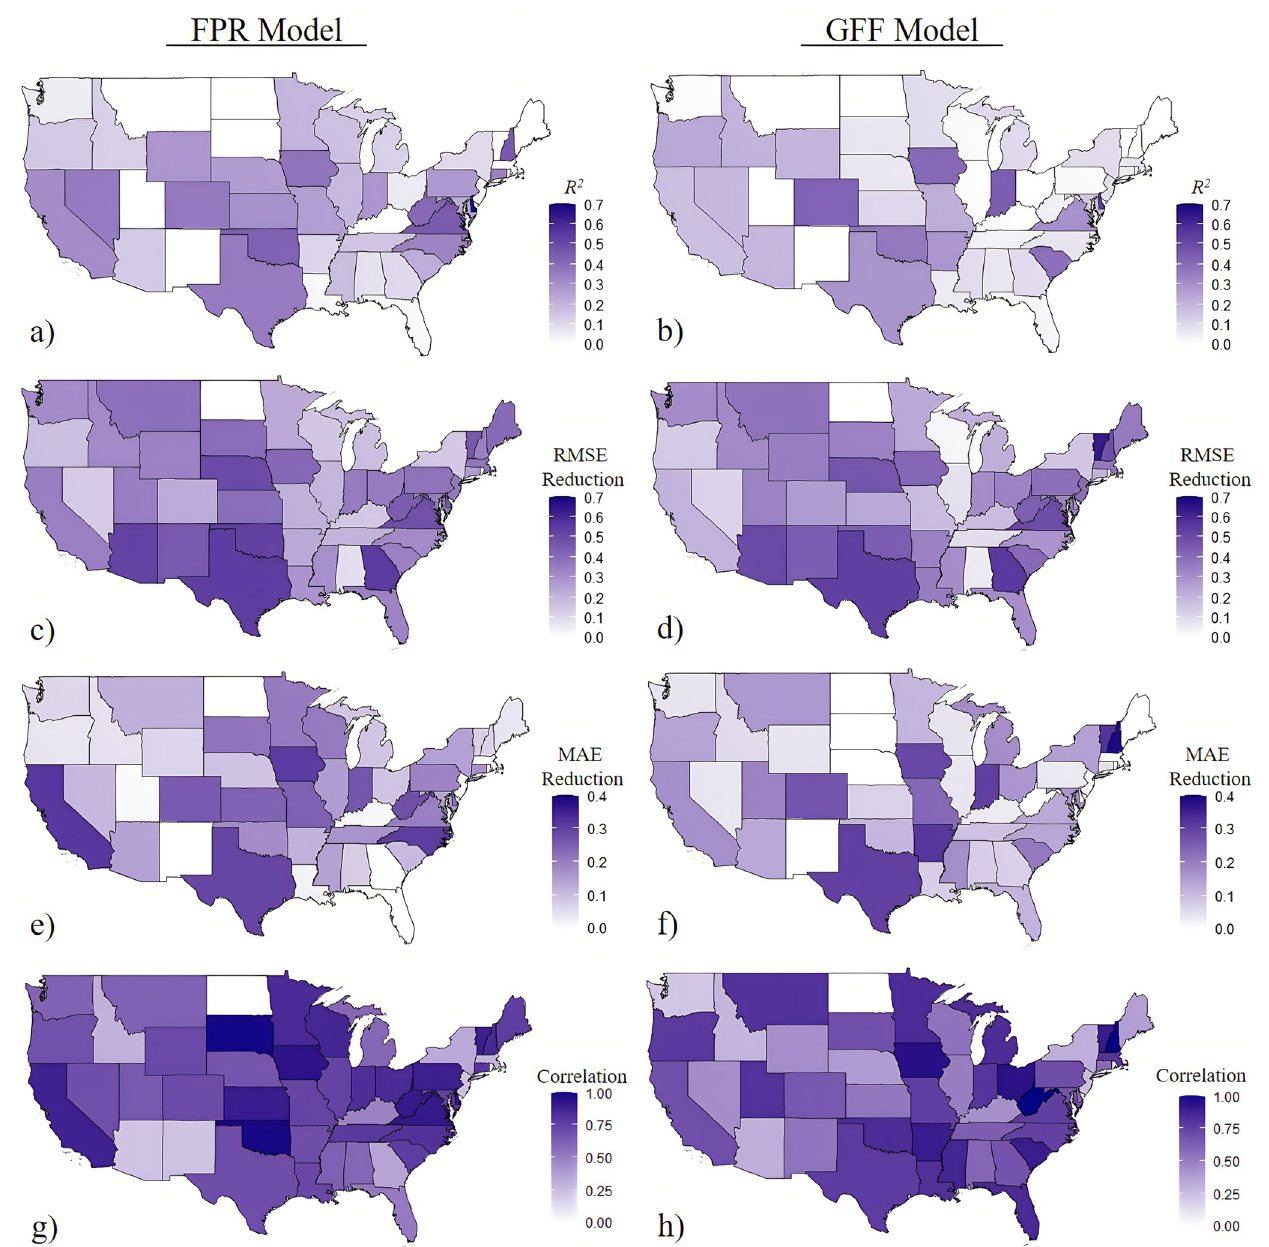
Fig 5. Predictive accuracy measures for each state using RF model. a. R 2 (FPR model), b. R 2 (GFF model), c. RMSE reduction compared to null model (FPR model, out-of-sample), d. RMSE reduction compared to null model (GFF model, out-of-sample), e. MAE reduction compared to null model (FPR model, out- of-sample), f. MAE reduction compared to null model (GFF model, out-of-sample), g. Correlation between predicted and actual values (FRP model), h. Correlation between predicted and actual values (GFF model). Note: MAE—Mean Absolute Error; RMSE—Root Mean Squared Error. The base map in this figure is from 2010 TIGER/Line Shapefiles, prepared by the U.S. Census Bureau. It is in the public domain and is not copyrighted [51].